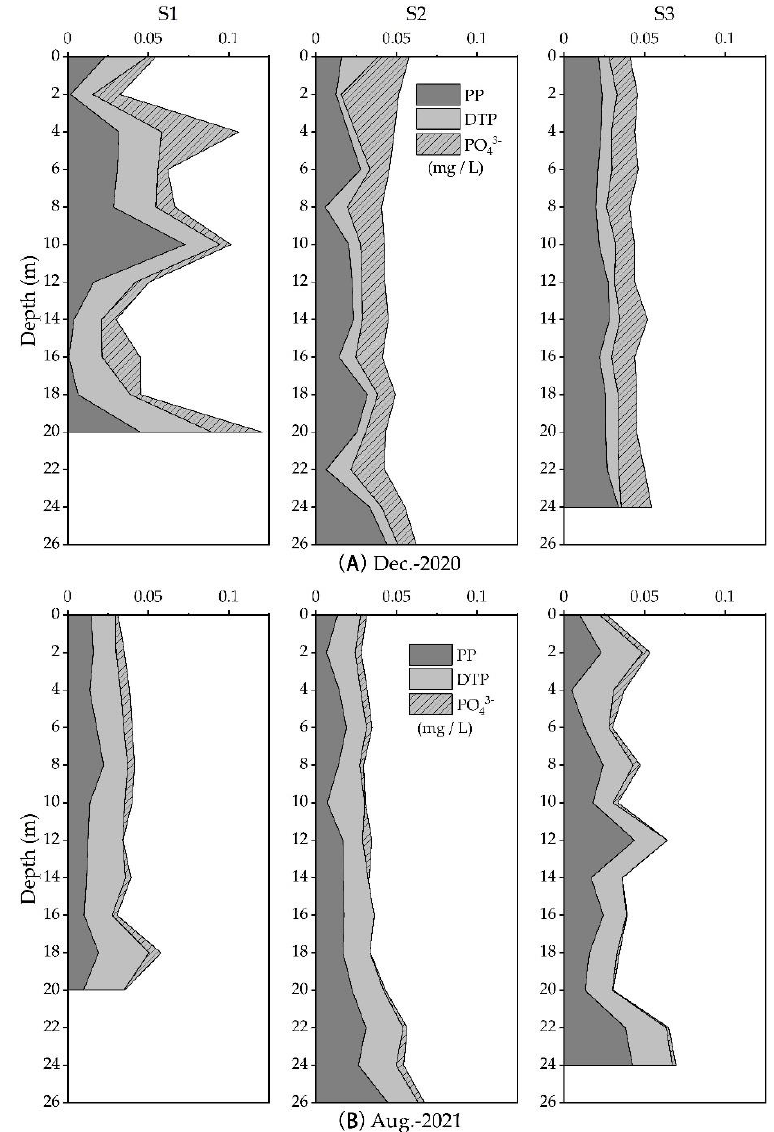
Figure 13. Phosphorus composition accumulation diagram in December 2020 and August 2021.